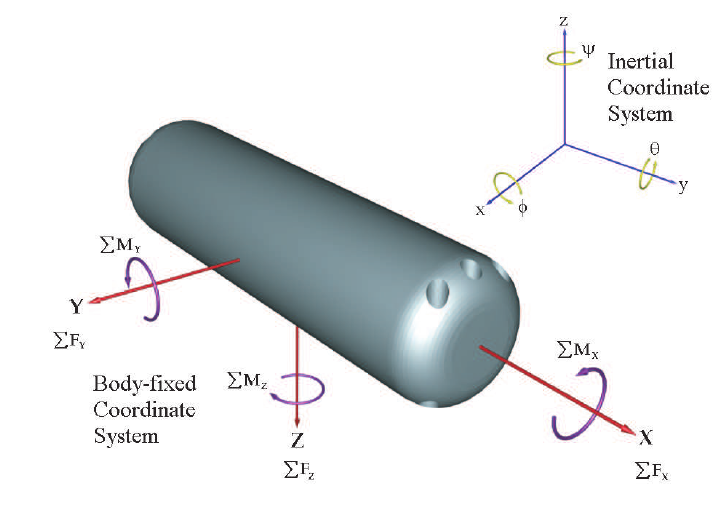
Figure 1 . Sensor Fish body-fixed and inertial coordinate